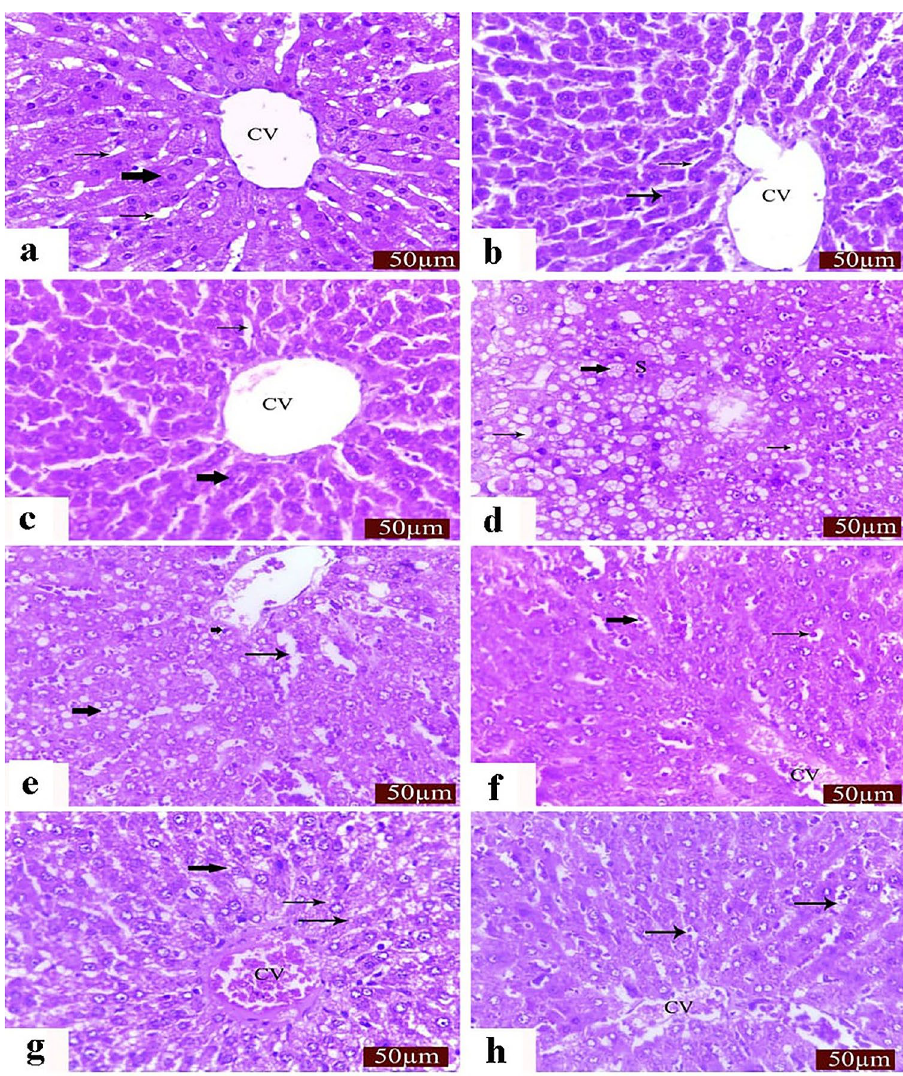
Figure 1. Histopathological changes in liver sections. ( a )–( c ) Normal organization of the hepatic cords (thick arrow), blood sinusoid (thin arrows), and central vein (CV) of the liver in the control ( a ), LP ( b ) and NAC ( c ) groups. CP-induced changes in the liver include severe degenerative changes, such as loss of normal hepatic cords arrangement, vacuolation (thin arrows), foamy appearance (thick arrow), and pycnotic nuclei of some hepatocytes (S). ( e ) CP-induced loss of normal cellular architecture of hepatic cords with severe hepatic vacuolation (thick arrow), dilated blood sinusoid (thin arrow), and pycnotic nuclei of hepatocytes (short arrow). ( f ) histological changes in the liver in the LP + CP group. Moderate effects in the liver include congested blood vessels (CV), dilated blood sinusoid (thick arrow), and condensation of nuclear chromatin of hepatocytes (thin arrow). ( g ) Histological changes in the liver in the NAC + CP group. Moderate effects in the liver include congested CV, hydropic degeneration (thin arrows), and degranulated cytoplasm of hepatocytes (thick arrow). ( h ) Histological changes in the liver in the LP + NAC + CP group. Mild effects in the liver include dilated blood vessels (CV) and blood sinusoid (arrows). Scale bar = 50